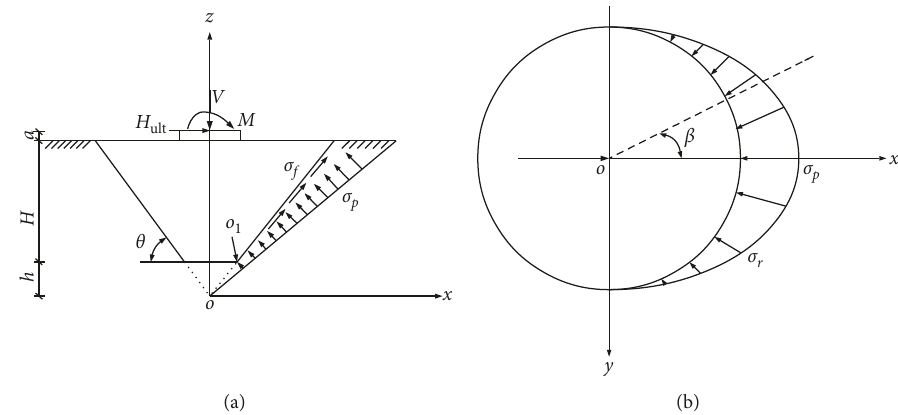
Figure 10: Distribution earth pressure along the surface of cone-shaped